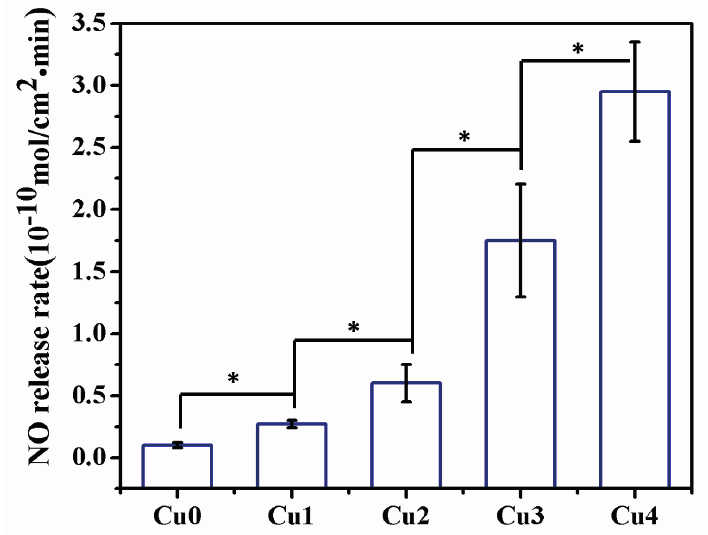
Figure 5. Catalytic generation of NO by Cu0, Cu1, Cu2, Cu3 and Cu4 samples using GSNO as the substrate (mean ± SD, * p < 0.05, n =